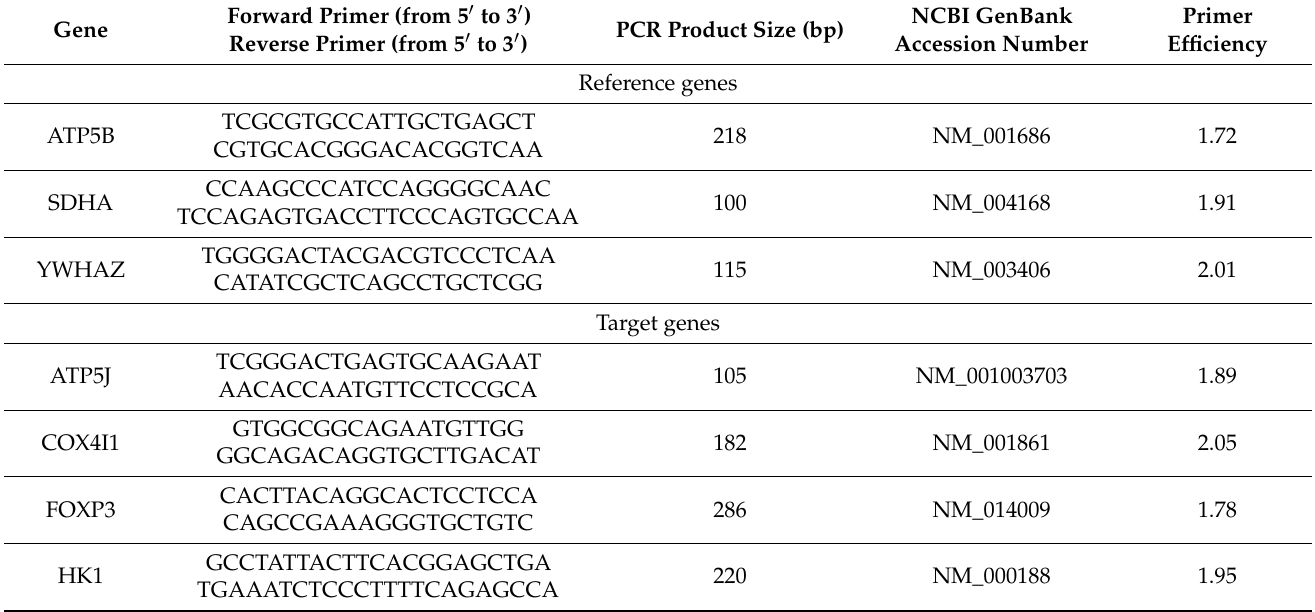
Table 1. Characteristics of gene-specific primer pairs used for